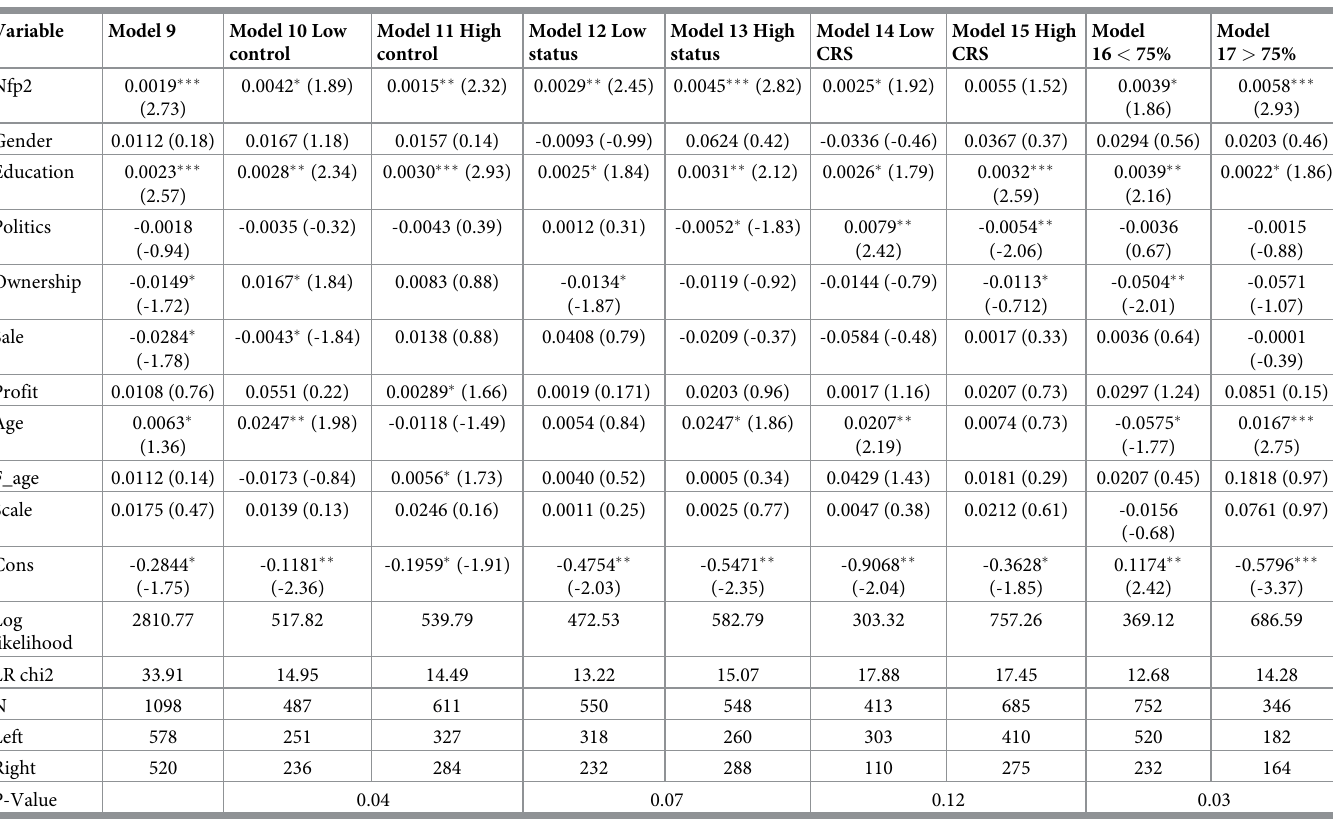
Table 3. Supplementary regression results with the change in the independent